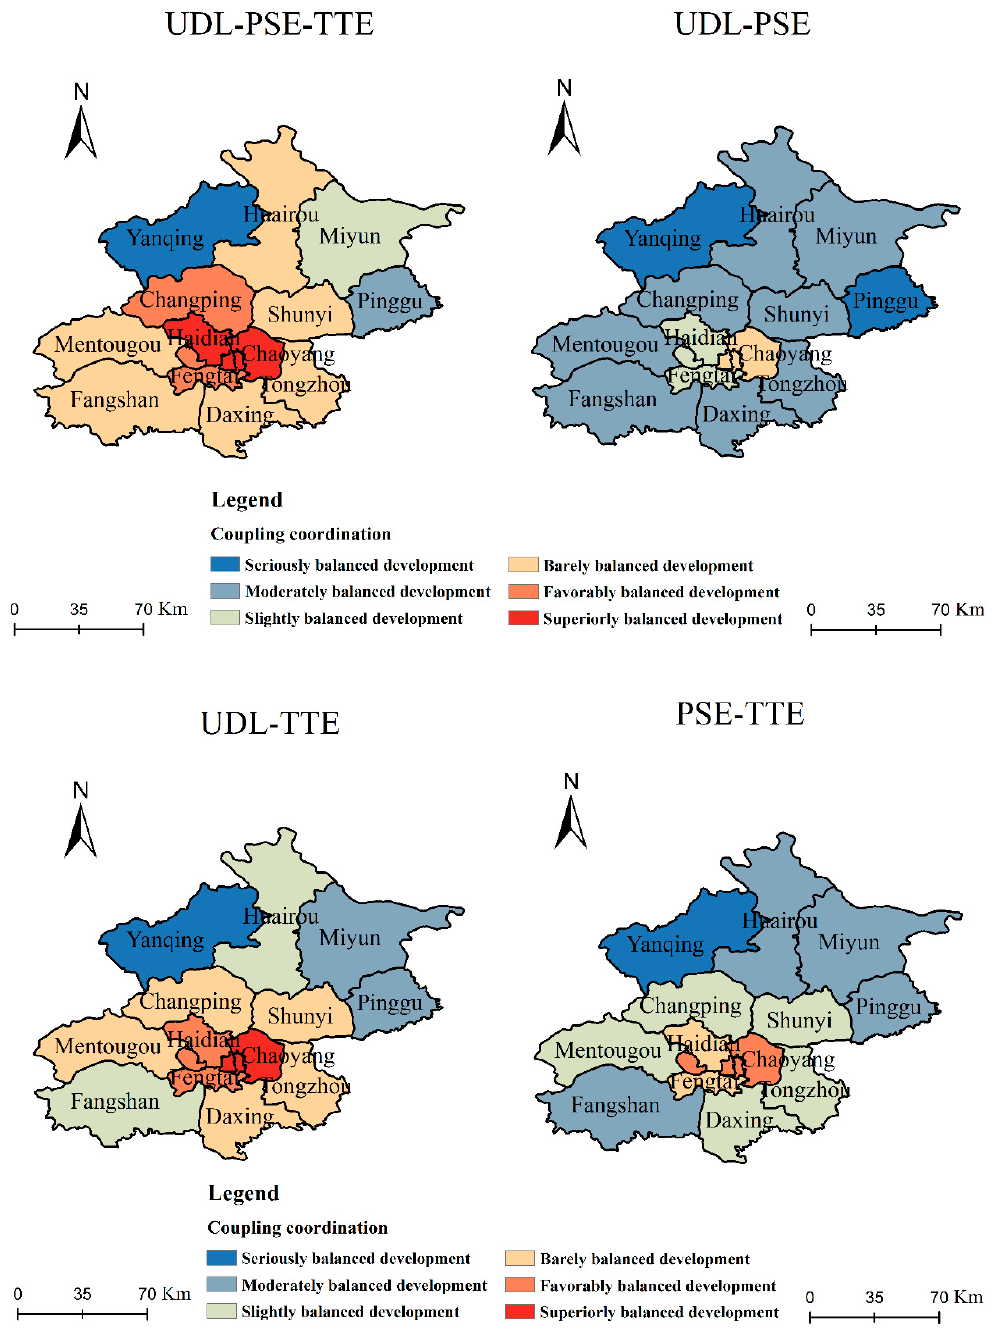
Figure 5. Spatial distributions of coupling coordination relationship across different regions. Looking at the pairwise coupling coordination relationship, the distribution of the UDL-PSE, UDL-TTE, and PSE-TTE coupling coordination relationships is obviously dif- ferent in each region (The coupling coordination degree results are from Figure 5). The coupling coordination relationship of UDL-PSE is more often falling into the